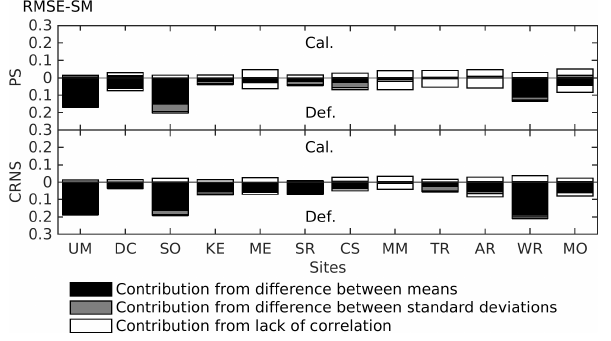
Figure 4. Objective function (RMSE; m 3 m − 3 ) values between ob- served PS/CRNS soil moisture and JULES simulated soil moisture. For each calibration the RMSE of the default run is shown from the horizontal axis down, and the result after calibration is shown in the upward directions. The different error contributions from the MSE decomposition are shown as stacked bar